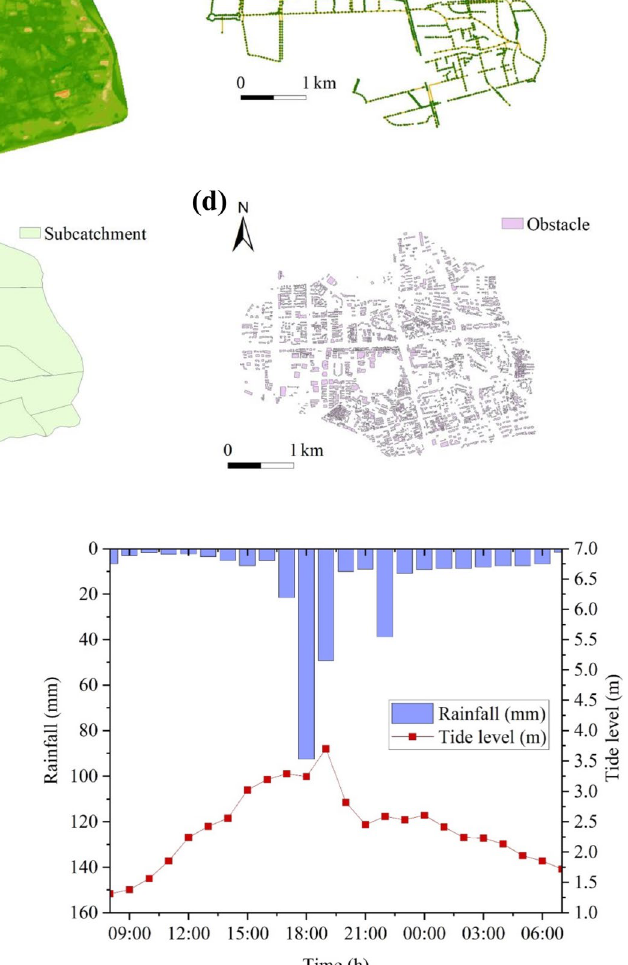
Fig. 4 Key data for the con- struction of the 1D-2D coupled flood simulation model based on the personal computer storm water management model (PCSWMM) on Hainan Island, China. a Elevation; b Distribu- tion of 1D inspection wells and pipelines; c Schematic diagram of subcatchment division; d Distribution of water blocking obstacles (mainly buildings)